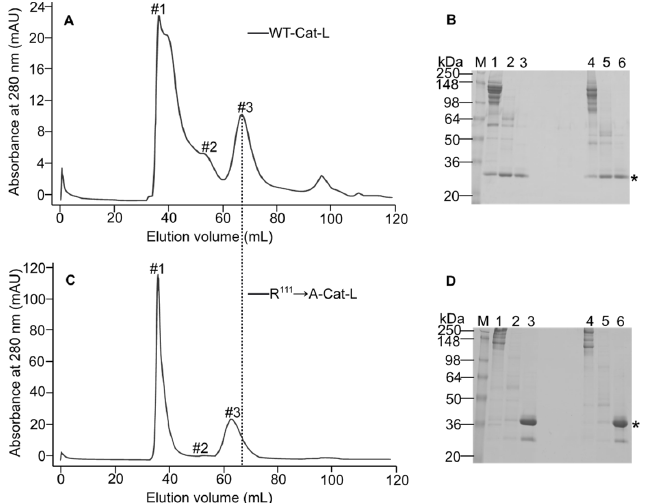
Figure 4. MT1 ‐ MMP catalytic domain is involved in the formation of the oligomeric structures. ( A ) Gel filtration elution chromatogram of WT ‐ Cat ‐ L truncated version. The recombinant enzyme was purified by affinity chromatography (IMAC) and then loaded on a sephacryl column. Peak #1 is the